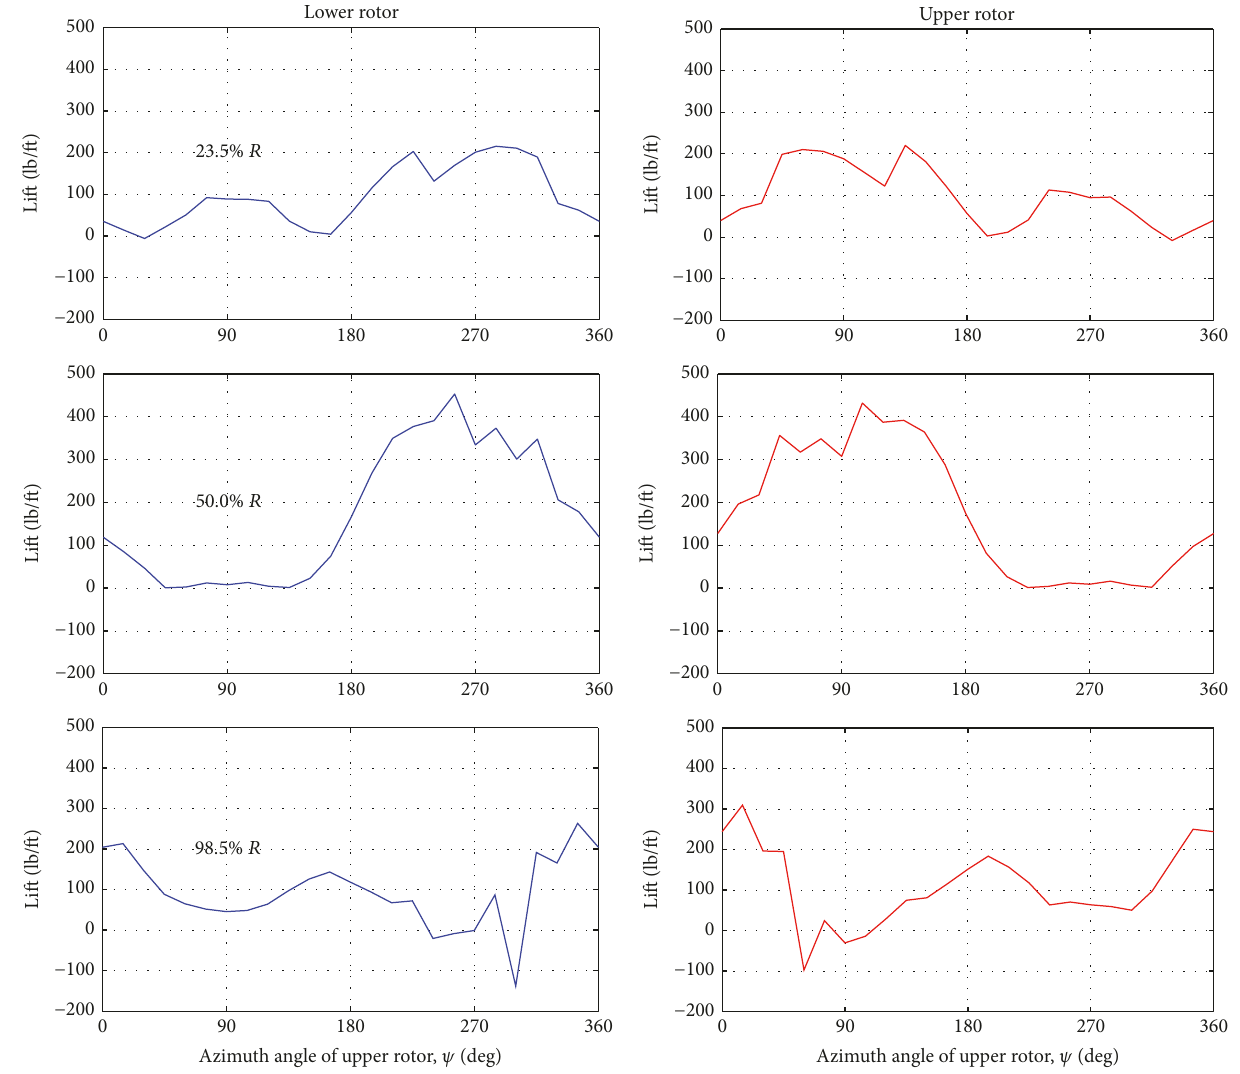
Figure 18: Blade section lifts at 240 knots in compound helicopter mode (LOS =